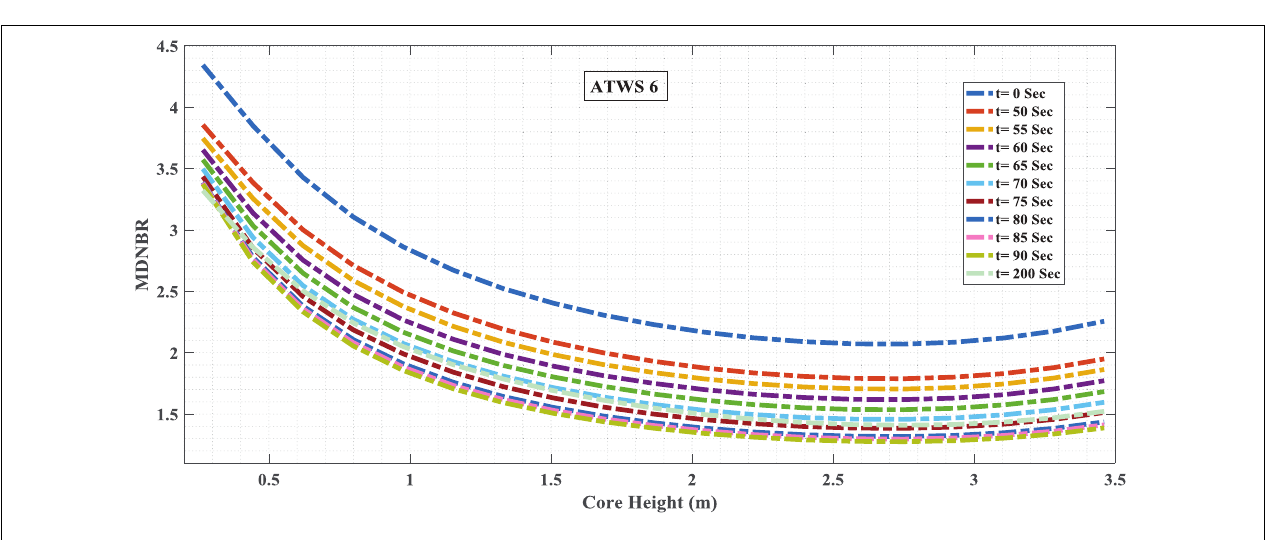
FIGURE 16 | MDNBR in core heights during ATWS 5.